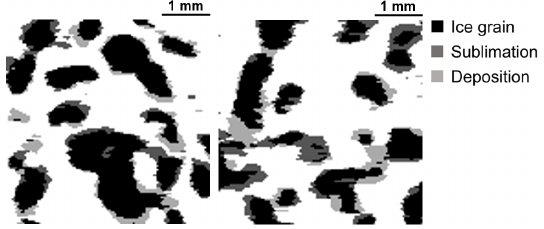
Figure 3. Superposition of vertical cross section parallel to the flow direction at 0 and 108h for ota3 (left panel) and ota4 (right panel). Sublimation and deposition of water vapor on the ice grains were visible with an uncertainty of 6% (a high-resolution figure can be found in the Supplement).